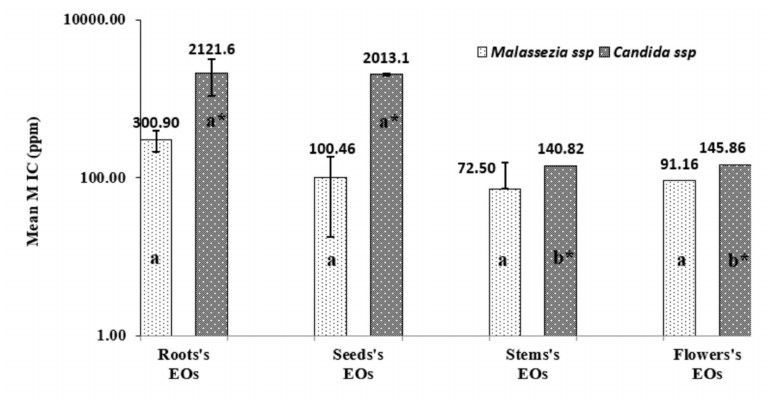
Figure 3. Mean MIC values of antifungal activity of the EOS from D. triradiata at genera level against selected strains from two fungus genera Malassezia and Candida .